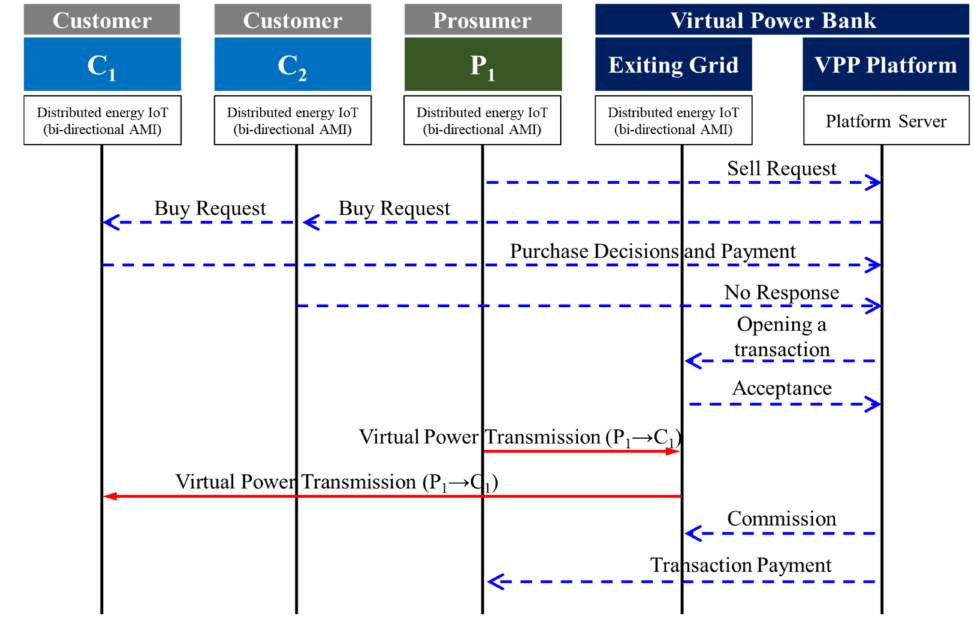
Figure 6. Flowchart of proposed